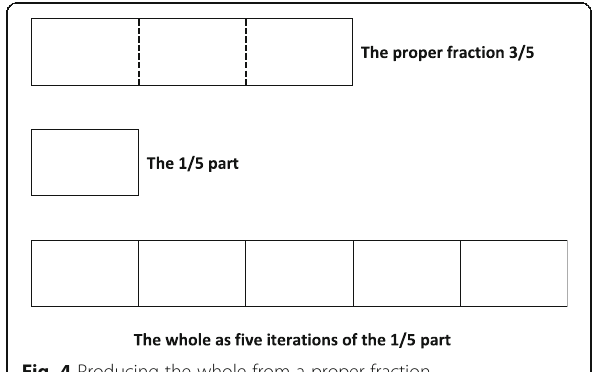
Fig. 4 Producing the whole from a proper fraction